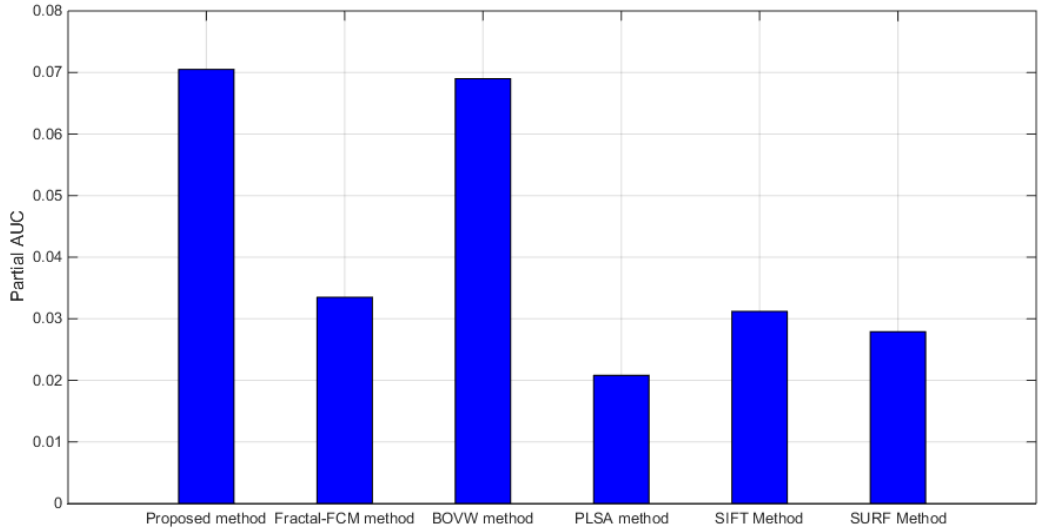
Figure 15. AUC of the proposed method and other methods.